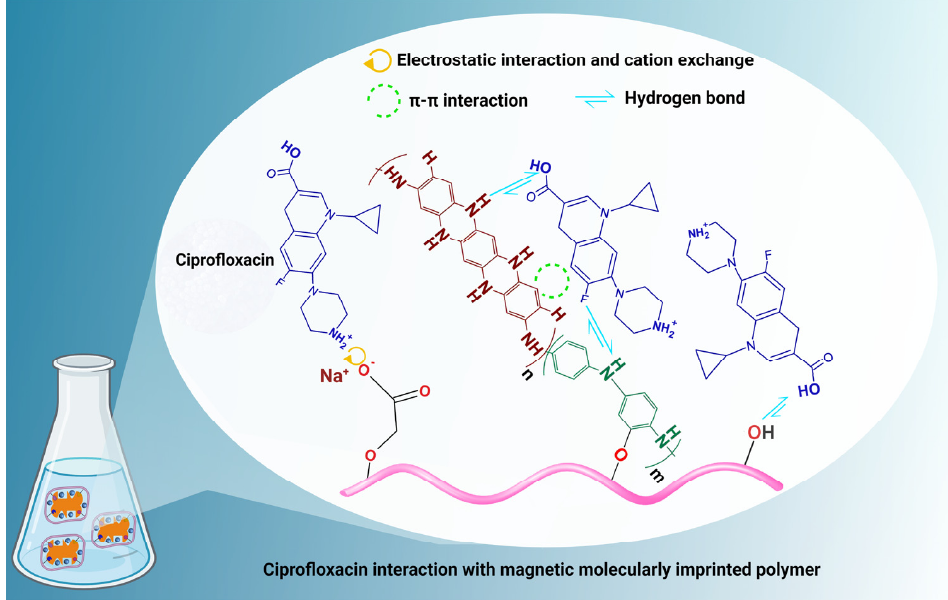
Figure 11. The suggested mechanism of ciprofloxacin adsorption on the MMIP.